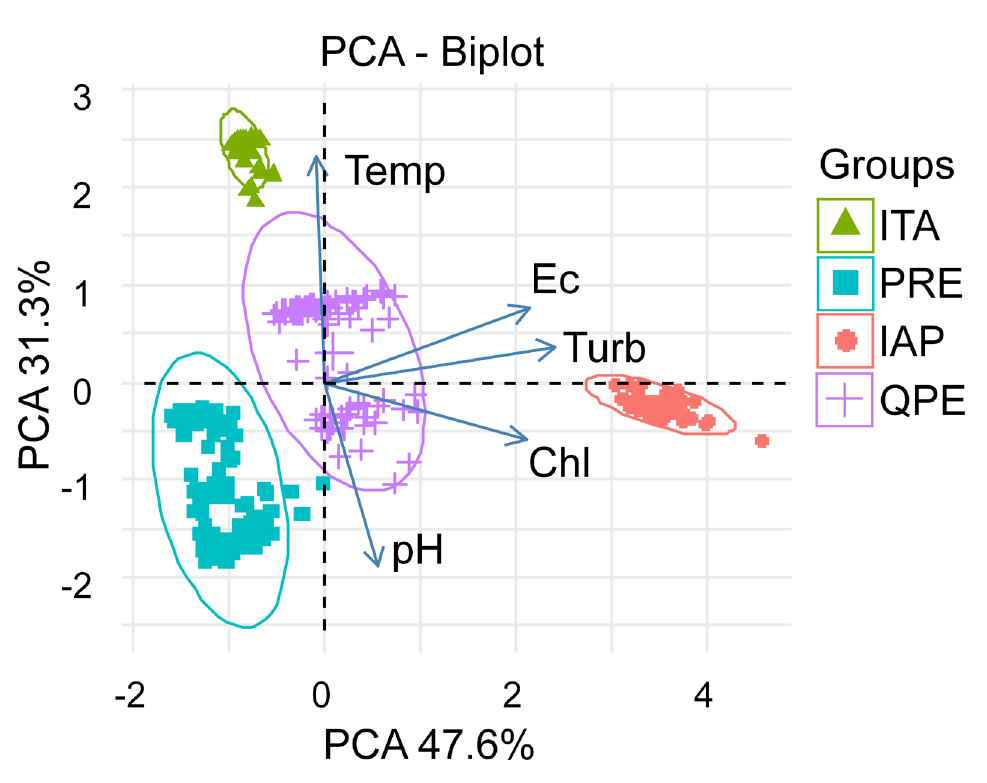
Figure 2. Results from the Principal Components Analysis (PCA) from the different sampling areas (ITA, PRE, IAP, and QPE) according to abiotic factors: pH, Ec (Conductivity), Turb (Turbidity), Temp (Temperature), Chl (Chlorophyll). The canonical axes explained 78.9 % of the variation. ITA: Itaúna stream, PRE: Preto stream, IAP: Iapó stream, QPE: Quebra Perna stream.